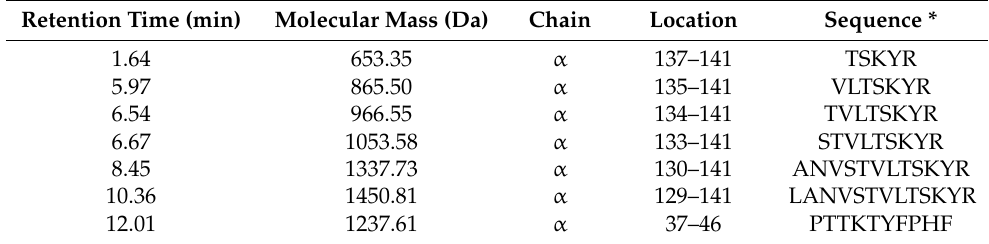
Table 2. Antimicrobial peptides recovered from the porcine cruor hydrolysate. Retention Time